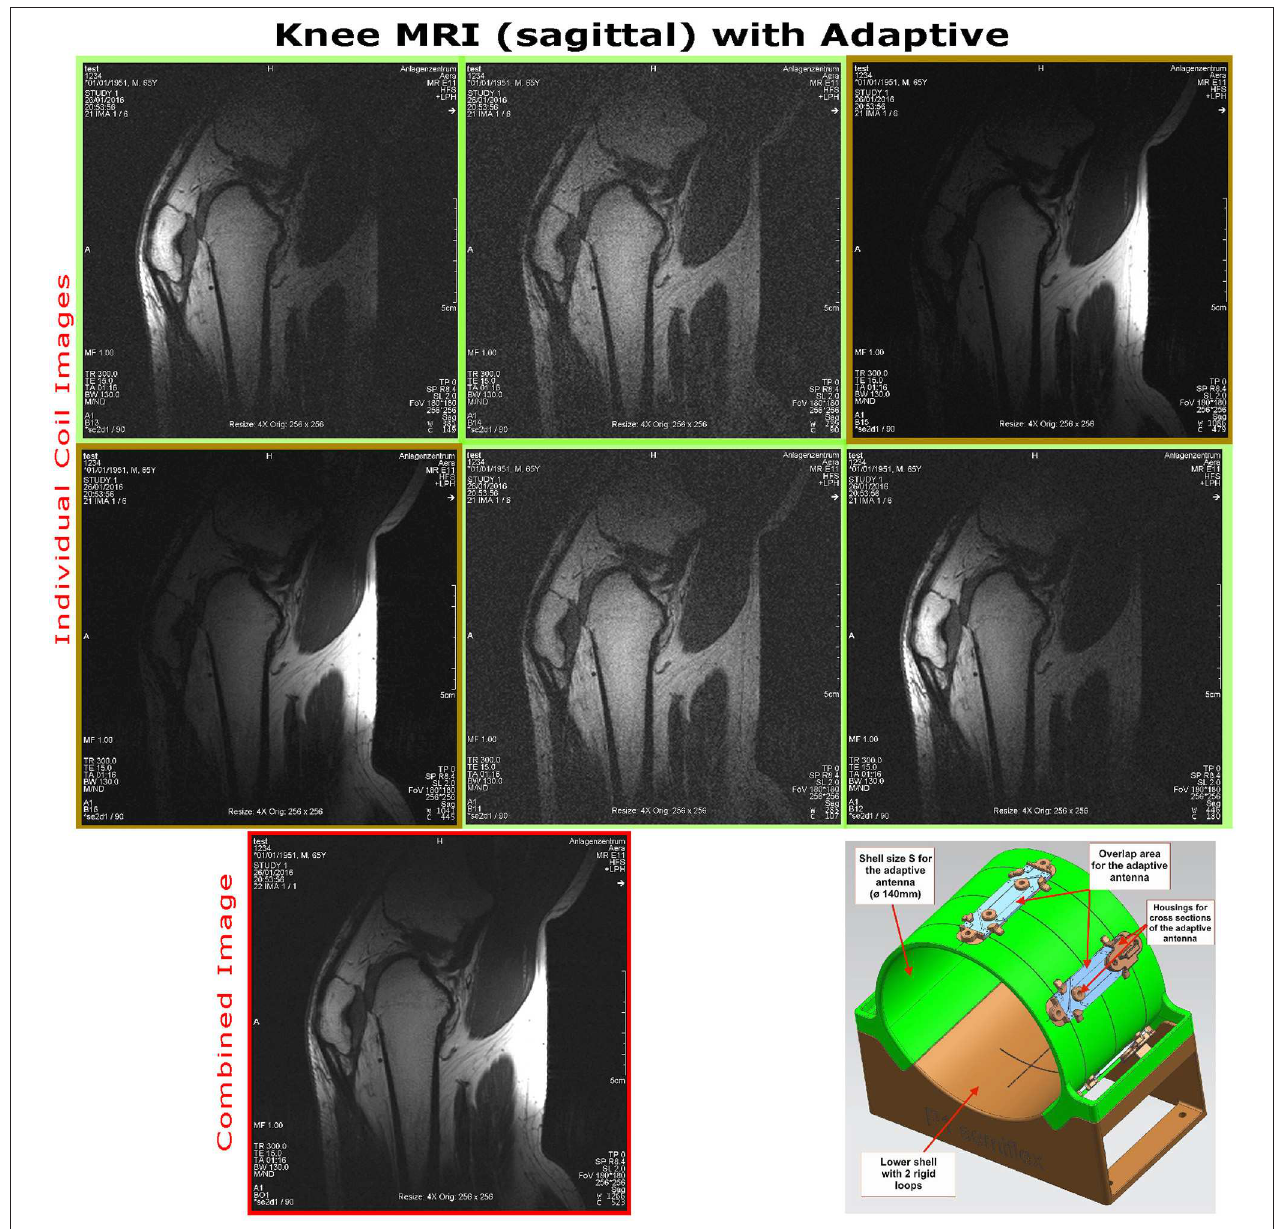
FIGURE 9 | MRI images of the individual channels from the 6ch adaptive array, imaging the right knee of a volunteer. Image 3 (1st row, 3rd column) and 4 (2nd row, 1st column) are from the 2 channels in the lower shell. The image was acquired using a spin-echo sequence in sagittal orientation (TE 180mm, TA 1:16min, slice thickness =